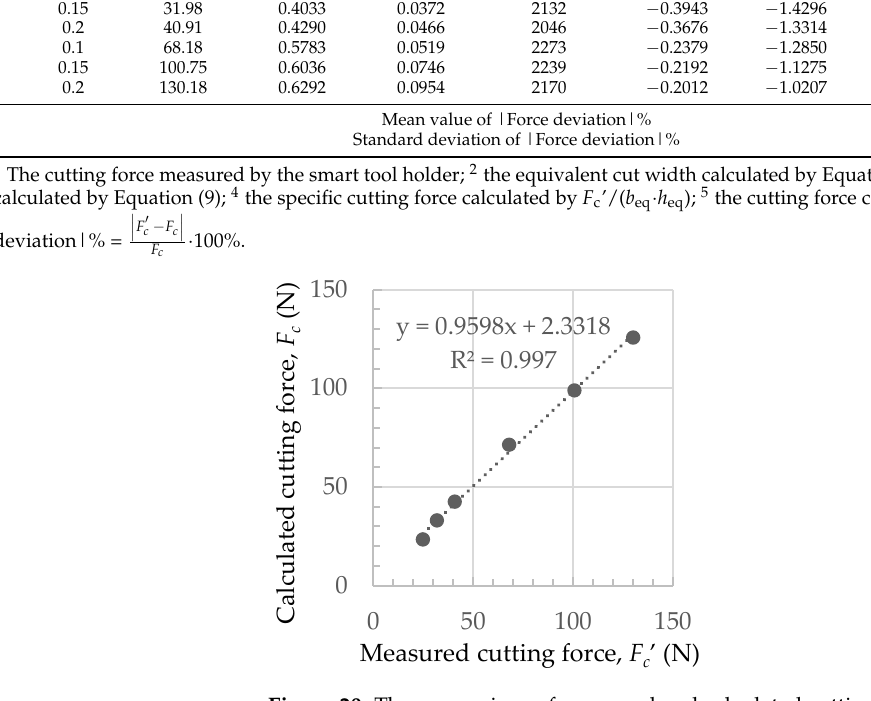
Figure 20. The comparison of measured and calculated cutting force in the fine turning of low carbon steel S15C.